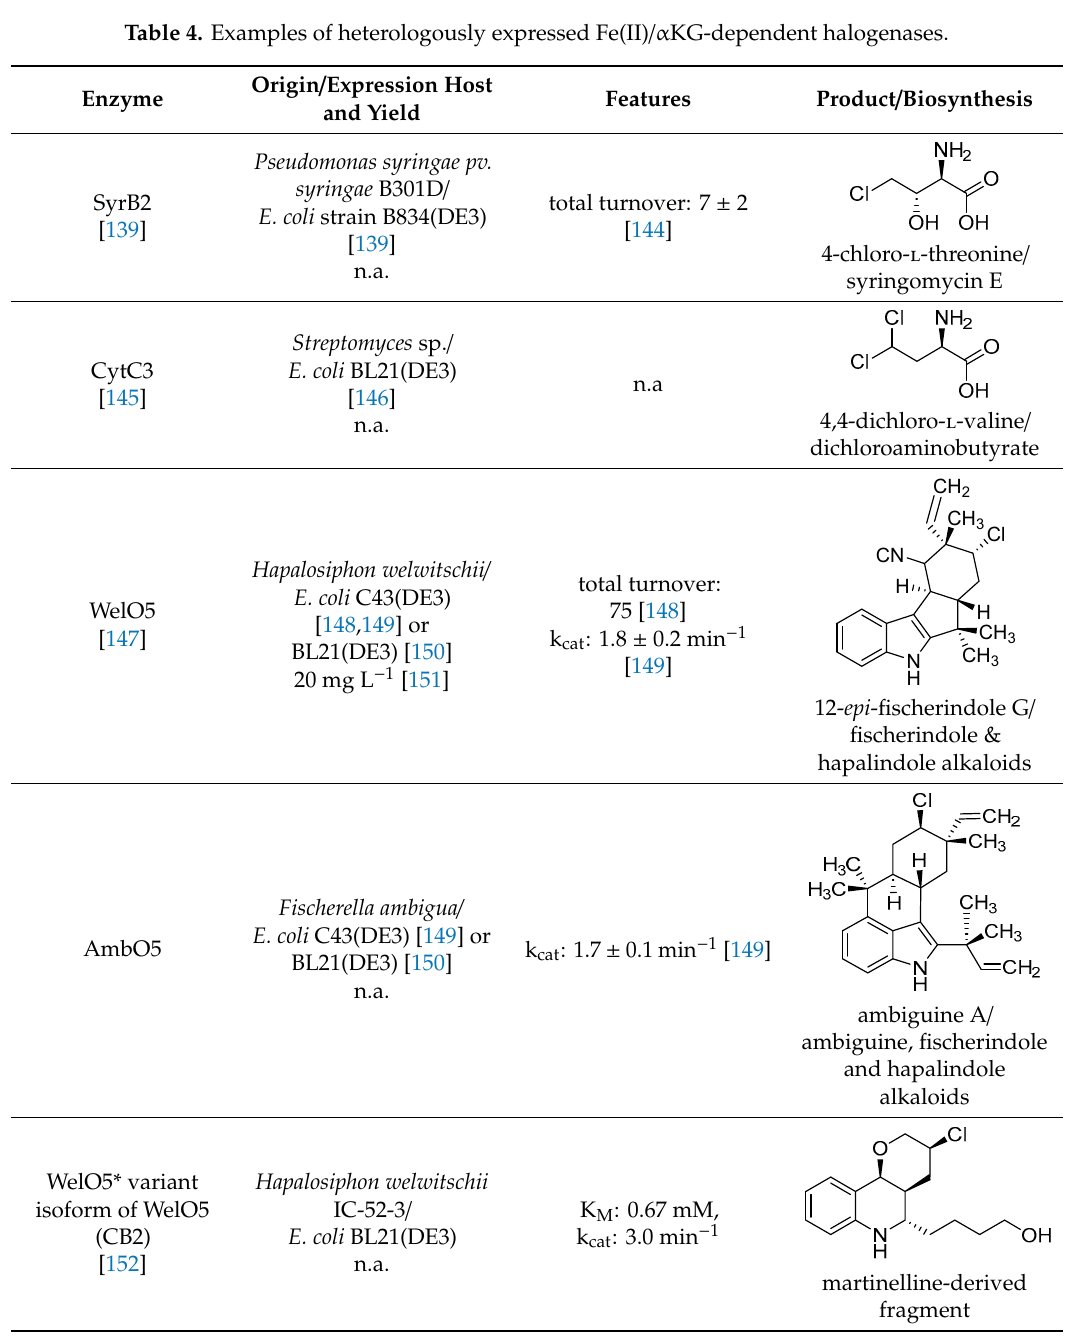
Features Product / Biosynthesis